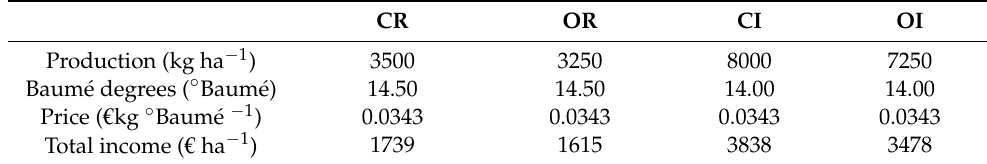
Table 5. Annual income of the four vineyard